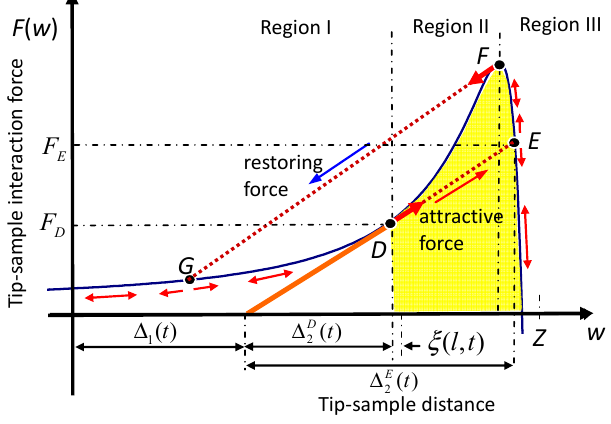
Figure 4. Schematics of tip-jump mechanism. When the microcantilever restoring force curve meets the tangent line at Point D (or F), a small disturbance may move the microcantilever from Point D (or F ) to Point E (or G